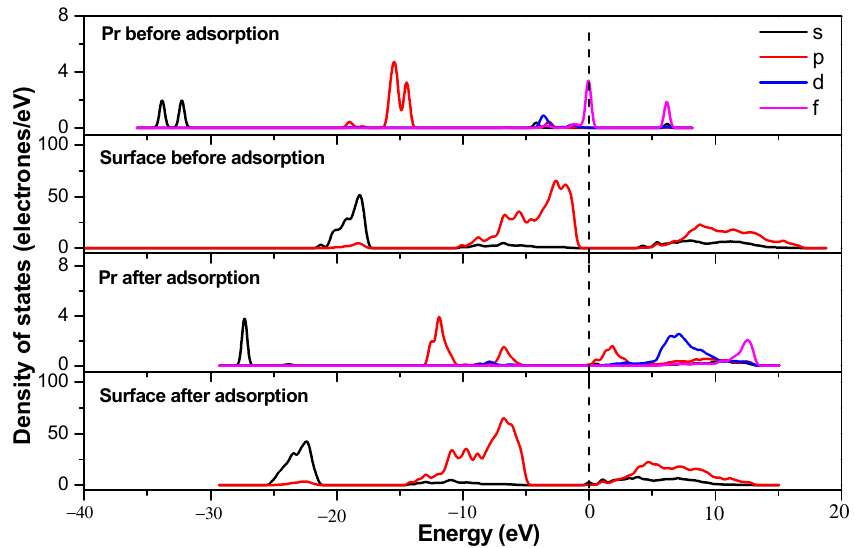
Figure 4. PDOS of Pr and (001) surface of Mt before and after adsorption. Table 4. Mulliken charges of Pr adsorbed on the (001) surface of Mt. Table 4. Mulliken charges of Pr adsorbed on the (001) surface of Mt.